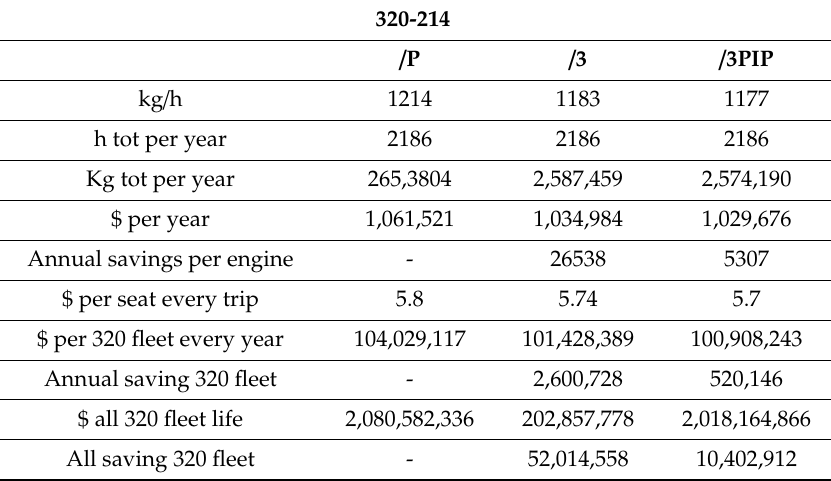
Table 4. Economic impact of upgrades in 320-214